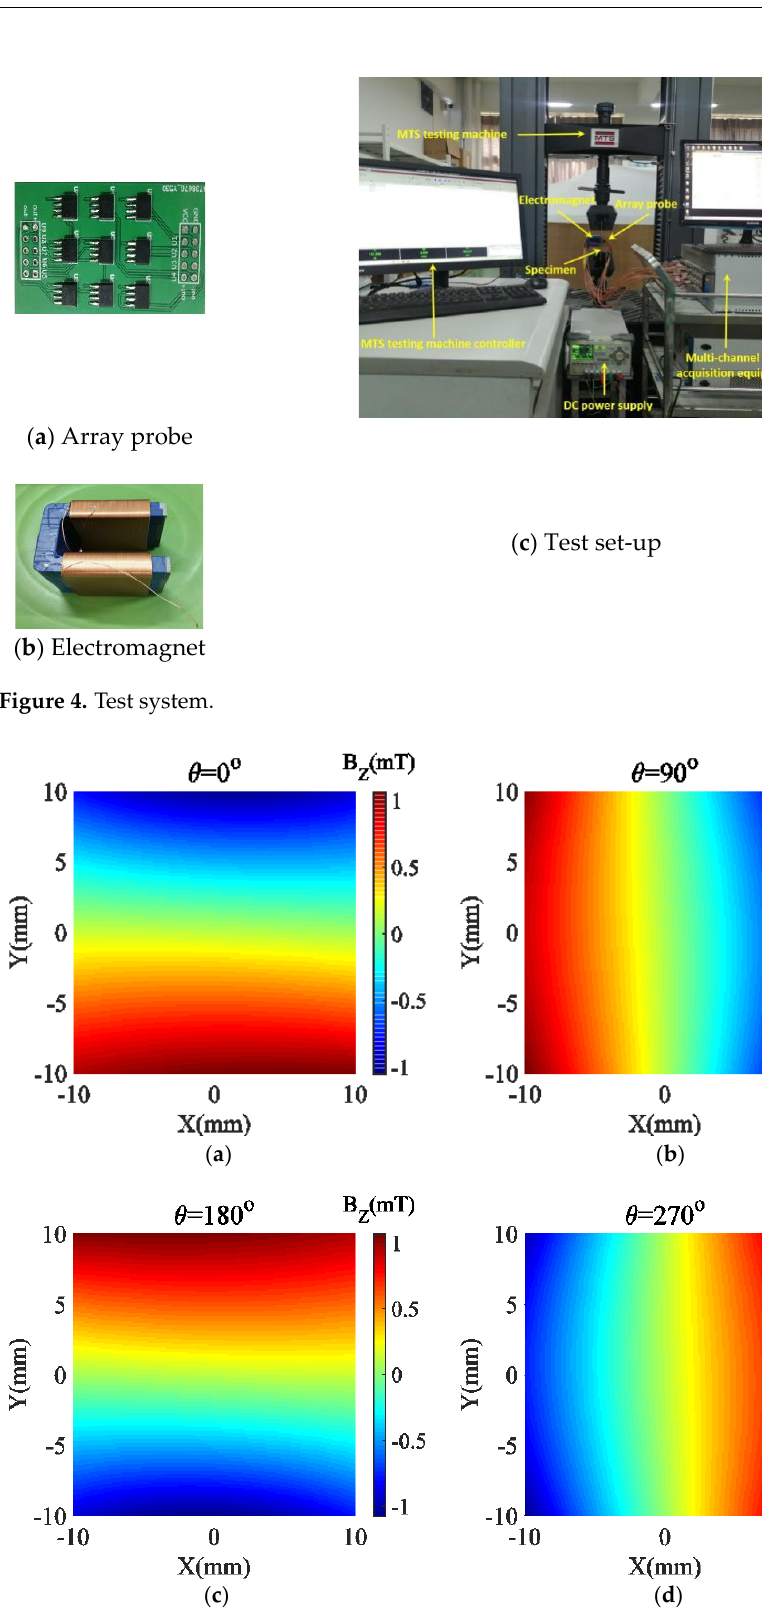
Figure 5. B Z distribution of the unloaded specimens under the DC magnetic field was applied at angles of ( a ) 0°; ( b ) 90°; ( c ) 180° ; ( d ) 270°. angles of ( a ) 0 ◦ ; ( b ) 90 ◦ ; ( c ) 180 ◦ ; ( d ) 270 ◦